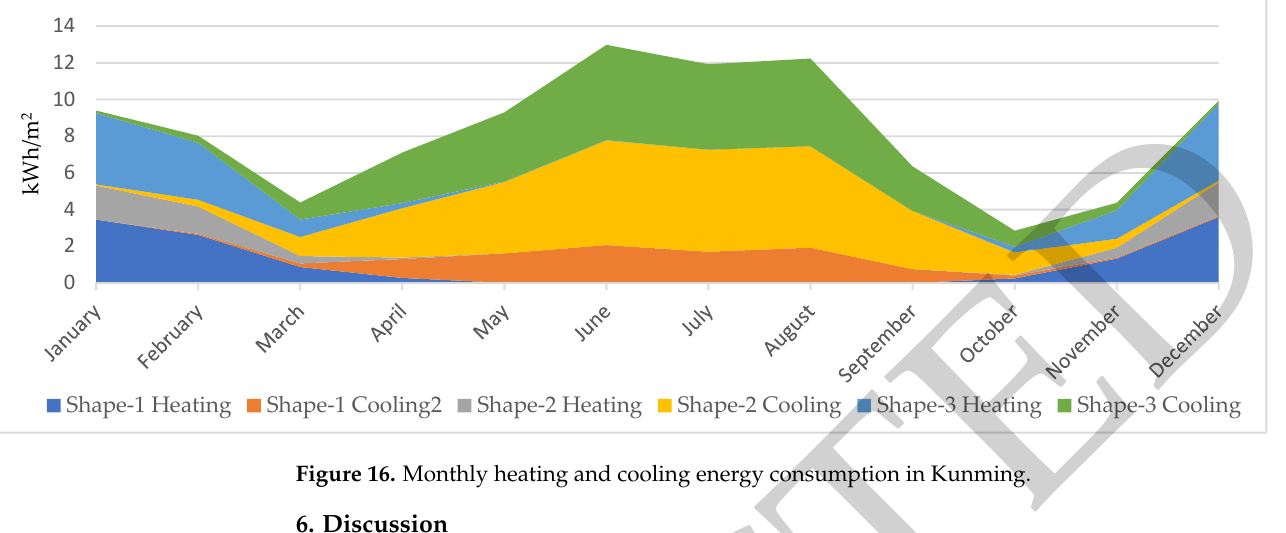
Figure 16. Monthly heating and cooling energy consumption in Kunming.